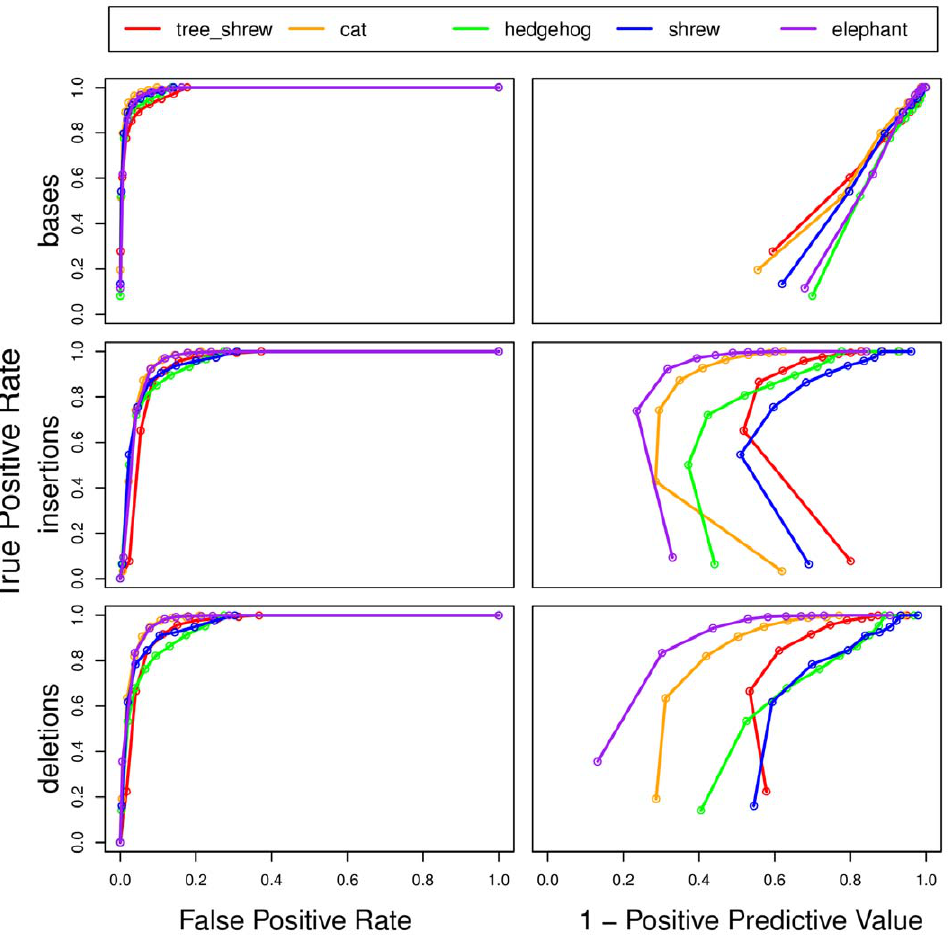
Figure 6. Receiver operating characteristic (ROC) curves for sequencing error mitigation. On the left, false positive rates (fractions of non- errors incorrectly masked or imputed) are plotted versus true positive rates (fractions of errors correctly masked or imputed) as the quality threshold is varied (see text). On the right is a similar plot with 1 minus the positive predictive value (indicating the fraction of masking or imputation decisions incorrectly undertaken) in place of the false positive rate. Results are shown for five representative 2 6 assemblies, with separate plots for basecall (top), insertion (middle), and deletion (bottom) errors. The results shown here reflect simple thresholding of quality scores (see also Figure 7).